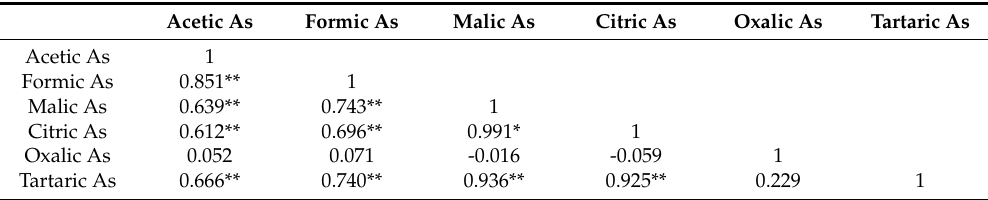
Table 1. Correlation matrices of six datasets involving various organic acid-extractable metals (1) As,